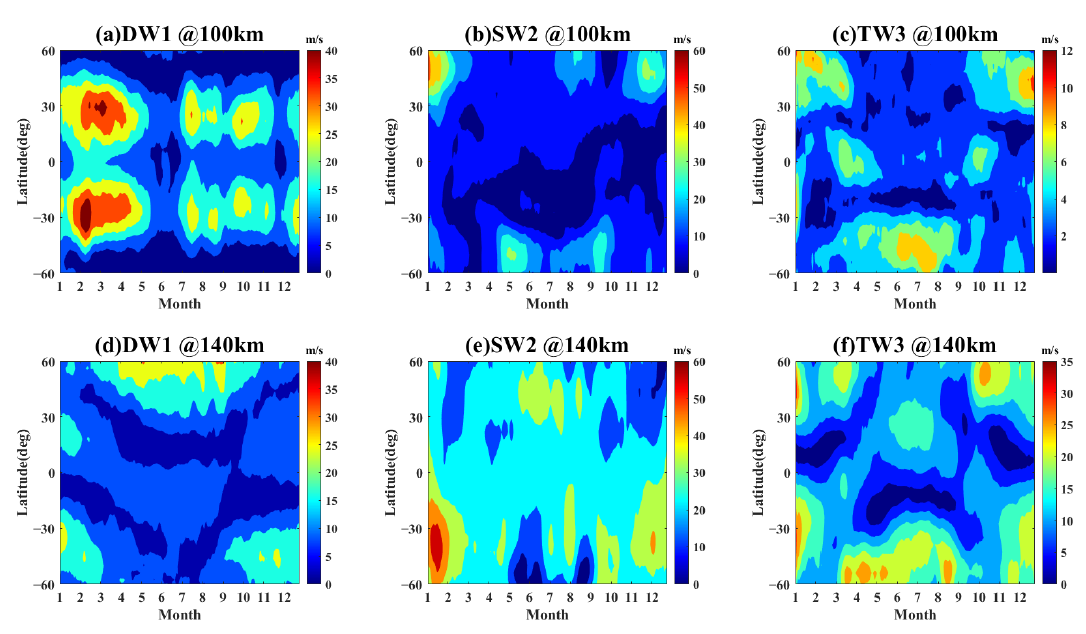
Figure 5. Seasonal variations of migrating tides ( a , d ) DW1, ( b , e ) SW2, and ( c , f ) TW3 at ( a – c ) 100 km, and ( d – f ) 140 km between 60 ° S and 60 ° N from 2003 to 2019.